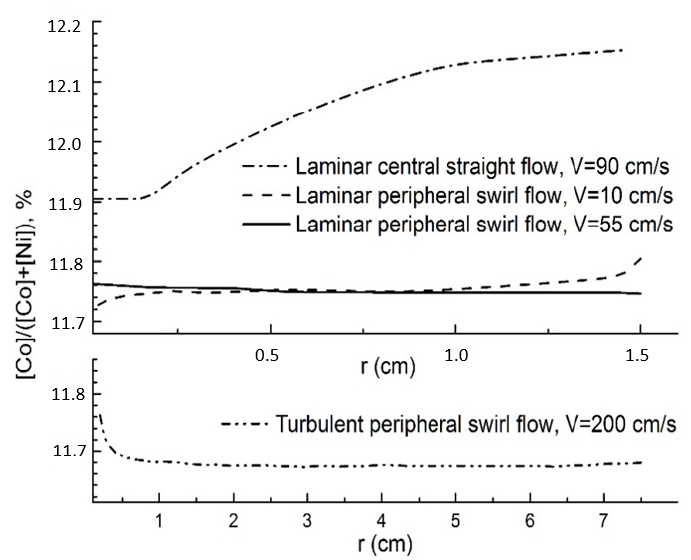
Figure 9. Radial profiles of Co concentration in KCNSH crystals grown in different hydrodynamic modes.